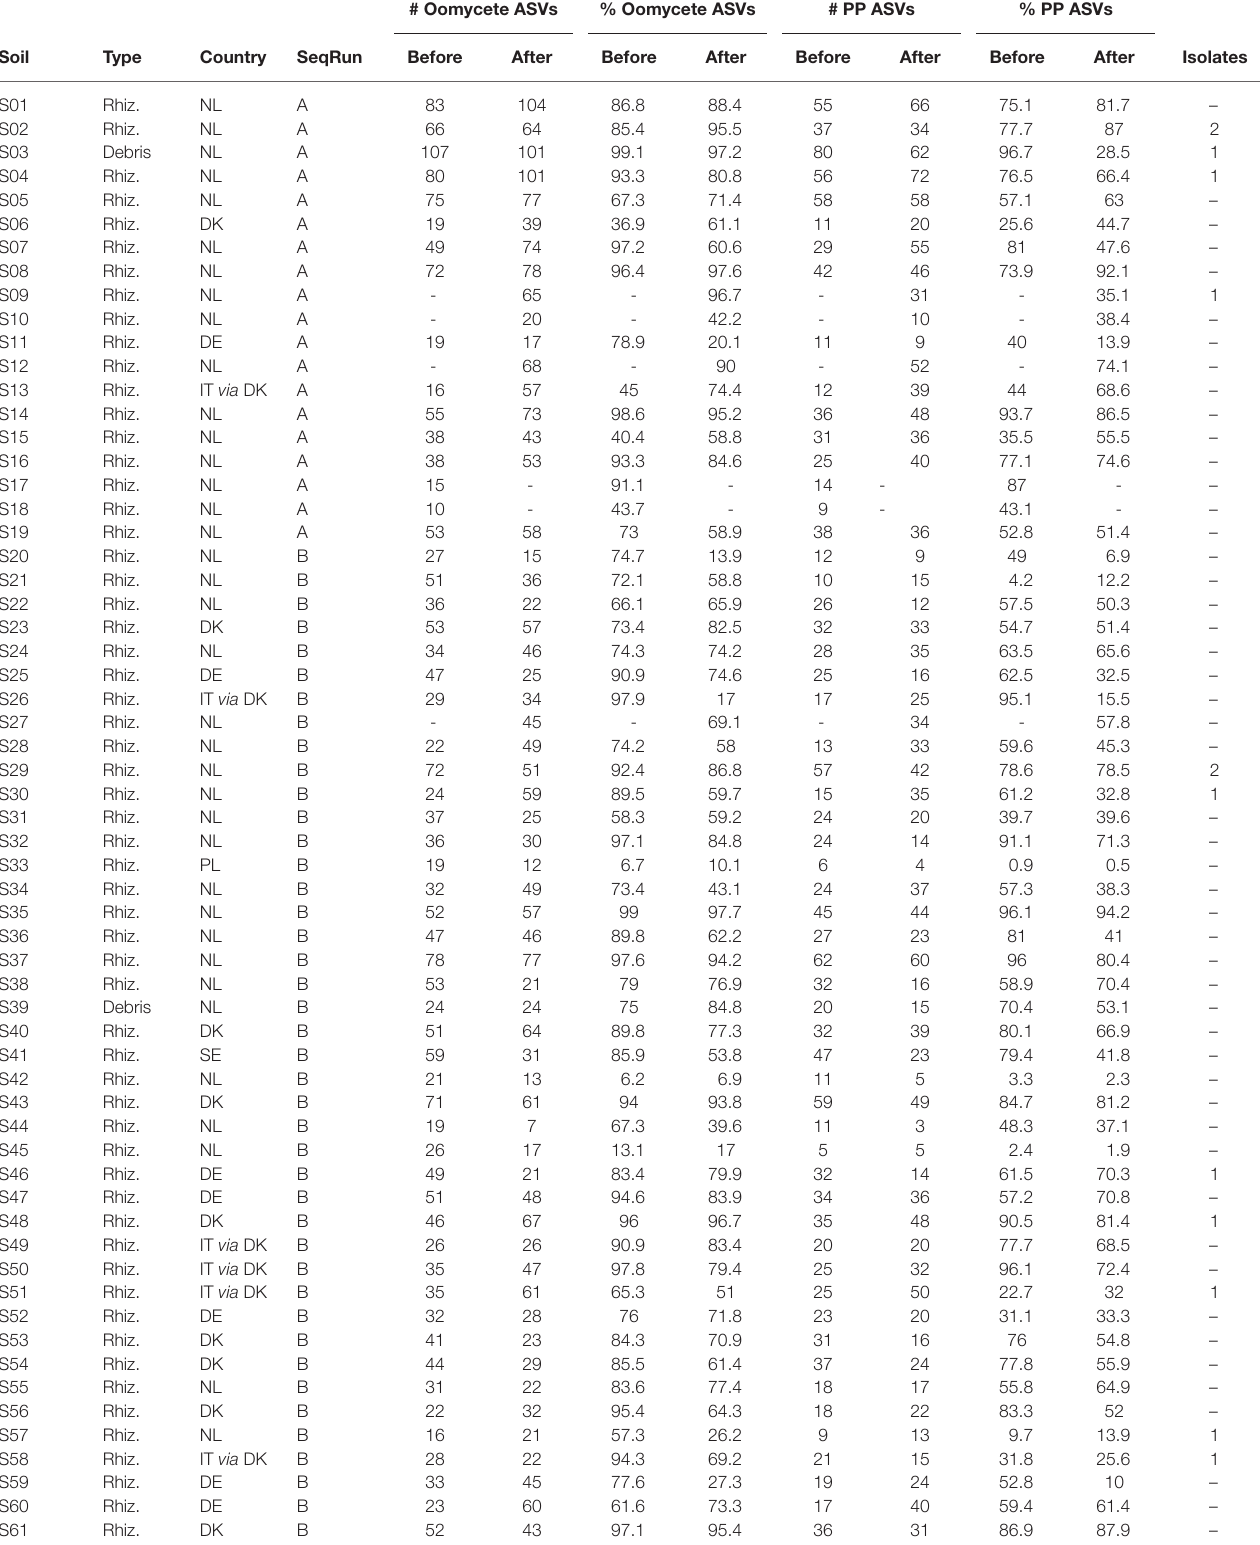
TABLE 1 | Overview of ASVs annotated as oomycetes and potentially plant pathogenic genera in soil samples before and after enrichment, and isolates after enrichment. # Oomycete ASVs % Oomycete ASVs # PP ASVs % PP